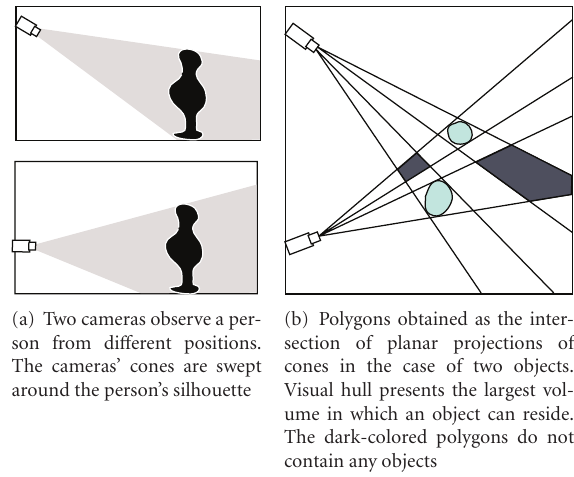
Figure 3: Finding the polygons that contain people based on a projection of the person’ silhouettes on the planar scene